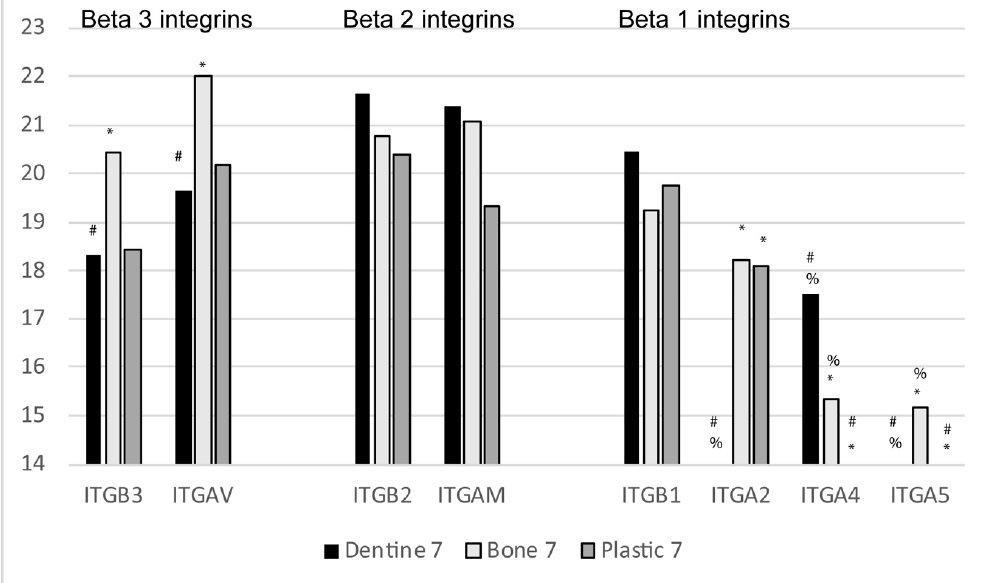
Figure 5. The relative abundance of the integrins (ITGB is integrin beta; ITGA is integrin alpha) found in osteoclast extracellular vesicles. AlphaV beta3 were found at higher levels in EVs from osteoclasts resorbing bone, compared with dentine or quiescent osteoclasts. Beta2 was found at higher levels in EVs from dentine. Our data suggest that beta1 integrin is found at higher levels in EVs from dentine. Alpha2 beta1 is probably found in all samples, although alpha2 was not detected in the EVs from dentine it was not detected in Day 7 dentine. Alpha4 beta1 may be found at higher levels in osteoclasts resorbing dentine and alpha5 beta1 may be more prominent in osteoclasts resorbing bone. Statistical analysis was performed from Z-scores as described in reference 25. Proteins with Z-scores greater than 1.65 or smaller than − 1.65 were considered significantly different. The following symbols are used; # indicates different from bone; % indicates different form plastic; * indicates different from